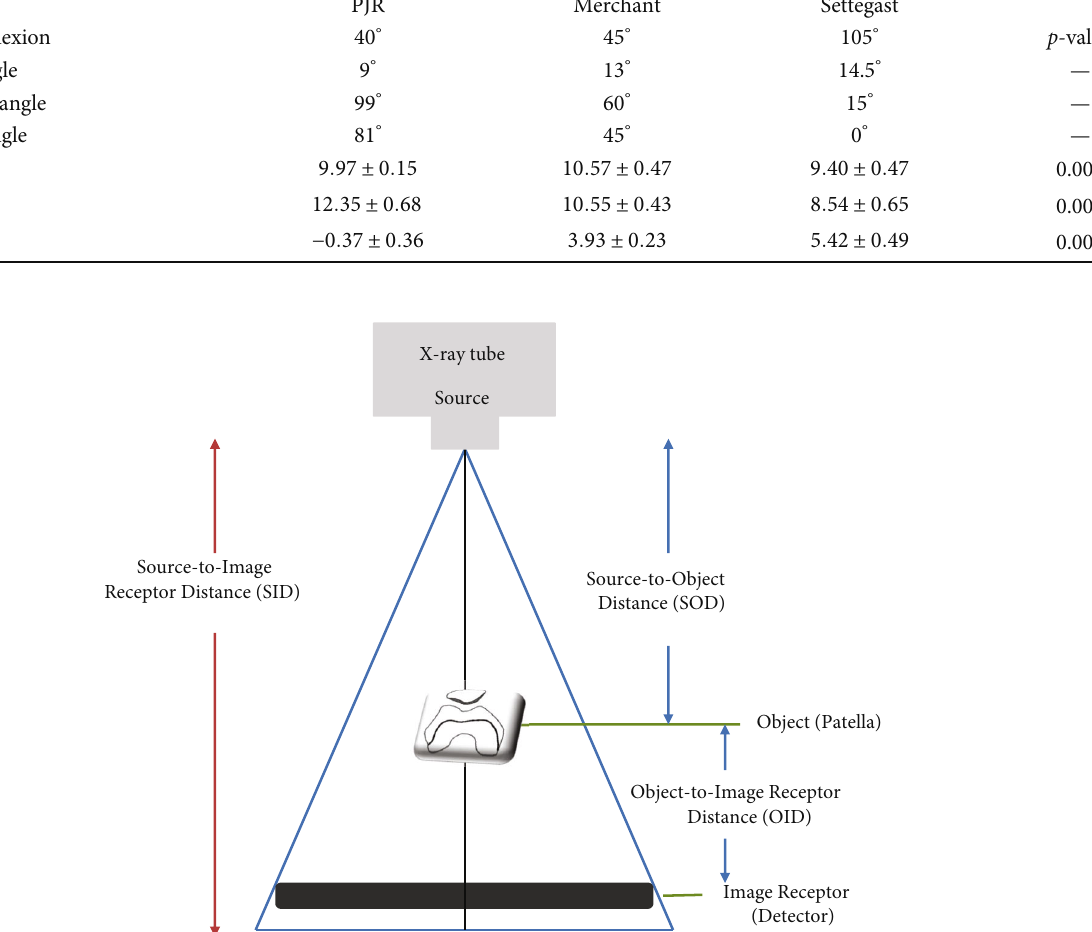
Figure 7: Fundamental concepts of source to image receptor distance (SID), source to object distance (SOD), and object to image receptor distance